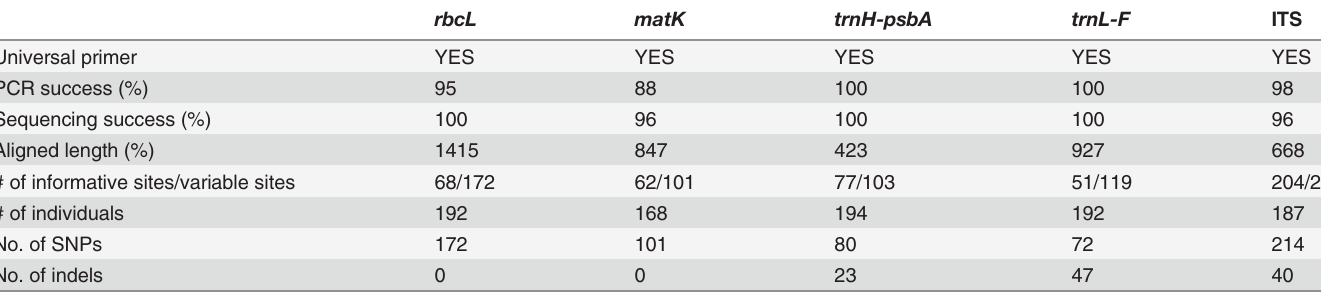
Table 2. Information used to evaluate the utility of the fi ve DNA barcoding